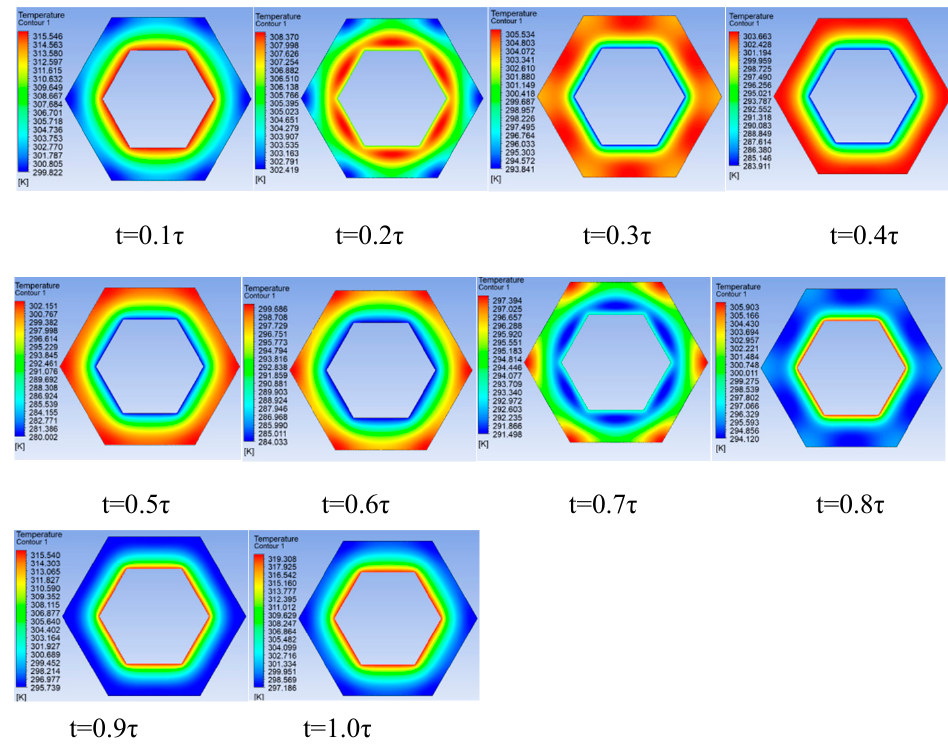
Figure 16. Temperature distribution cloud diagram of regular hexagonal tube at different times. The numerical solution of the regular hexagon tube was compared with that of the circular tube. The result is shown in Figure 17a, where 1 and 2 are the two endpoints of the regular hexagon (Figure 2b); the dashed line stands for the numerical solution of the circular tube. The error between the end points 1 and 2 of the regular hexagonal tube and the circular tube is shown in Figure 17b.